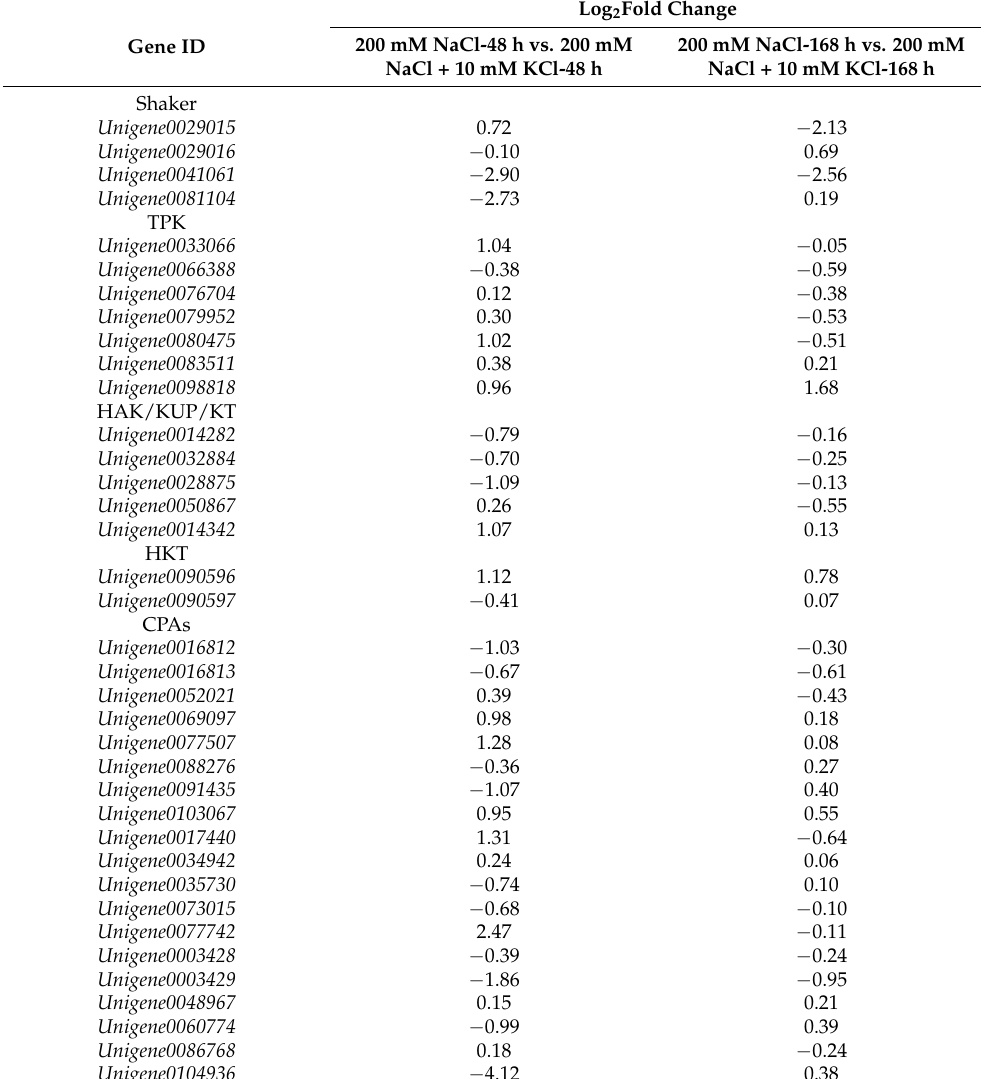
Table 4. Changes in the expression of K + channel- and transporter-related genes in the roots of T . ramosissima by exogenous potassium application under NaCl